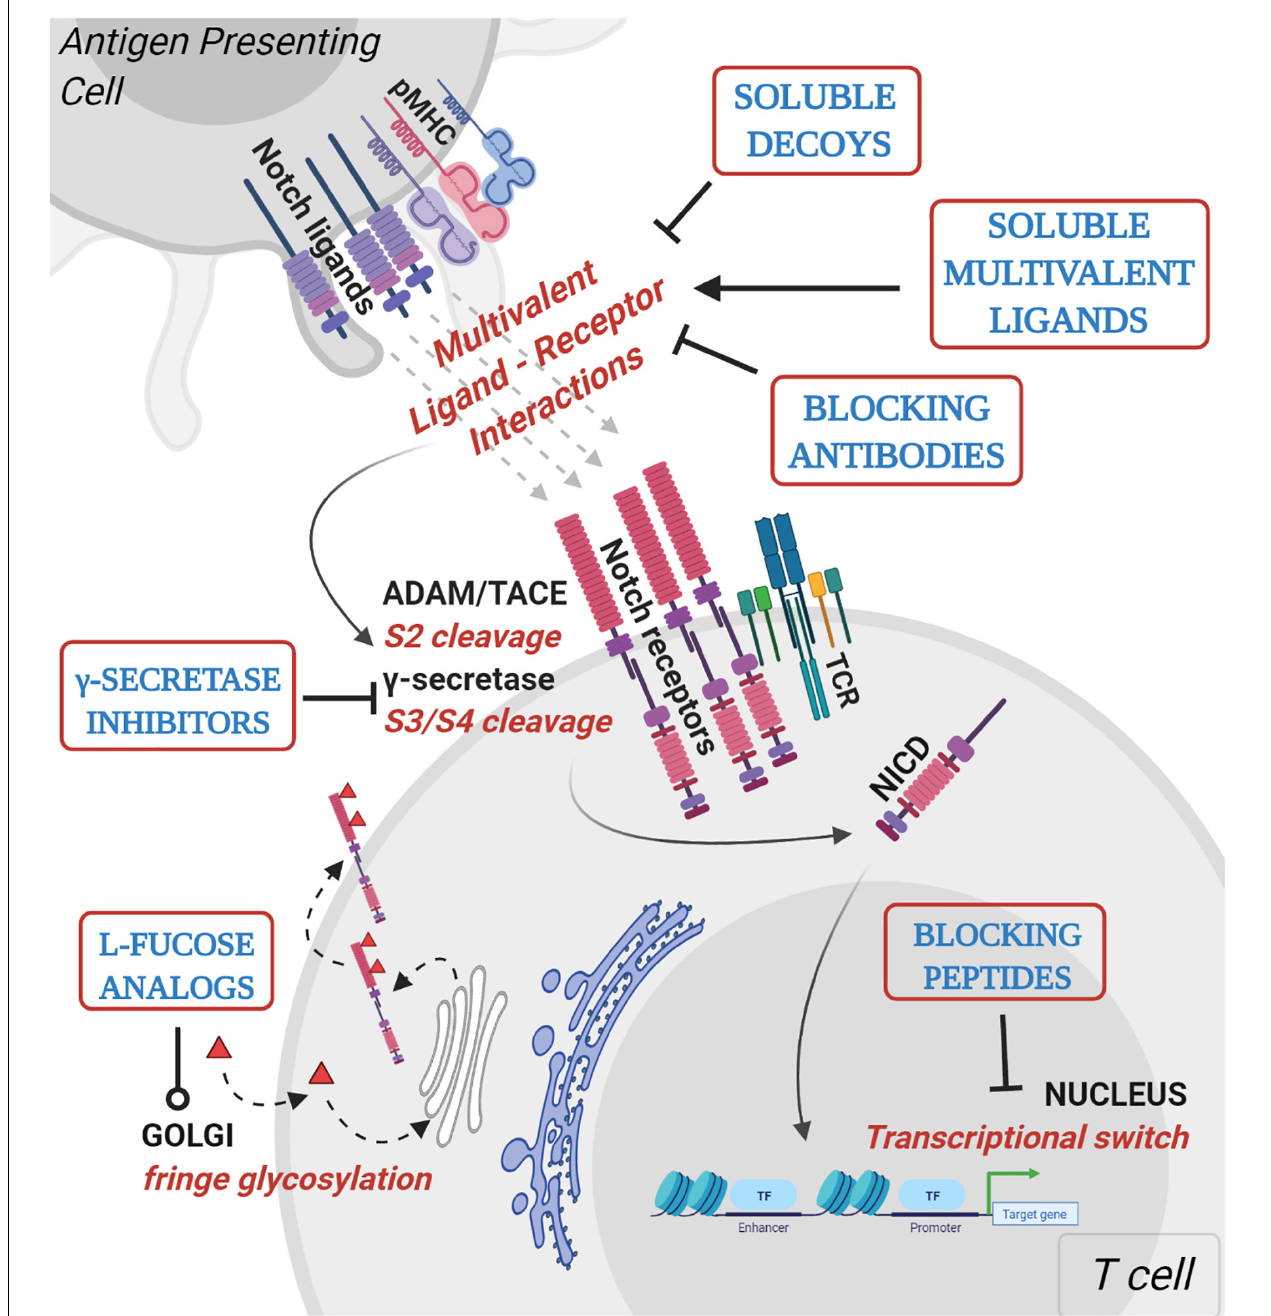
FIGURE 2 | Mechanistic basis for therapeutic targeting of ligand-specific Notch signaling. Agents targeting Notch signaling can be grouped by the step or process in the Notch signaling pathway that is being affected. Soluble decoys comprise of extracellular portions of Notch ligands or receptors that can competitively inhibit multivalent receptor-ligand interactions. Soluble multivalent ligands comprise of clustered ligands that provide and/or augment ligand-specific Notch activation. Blocking antibodies block receptor interactions with ligands and are paralog-specific antagonists with high selectivity. γ -secretase inhibitors prevent NICD release by inhibiting S3 cleavage of Notch receptors at the juxtamembrane domain. L -fucose analogs (solid red triangles) are taken up by cells from media and incorporated into receptor extracellular domains. Fucose analogs on Notch receptors alter ligand-binding affinities and can be used to block selective ligand interactions. Blocking peptides target protein-protein interface in the nuclear Notch transcriptional complex and prevent transcription of Notch target genes. In vitro , pre-clinical and clinical studies demonstrating Notch-modulatory activities and anti-tumor efficacy of various classes of Notch therapeutics are presented in Table 1 .